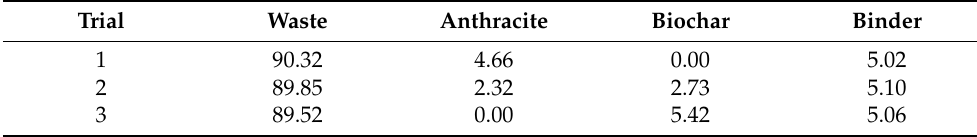
Table 1. Concentration of the components for the different mixtures of pellets (wt.%).